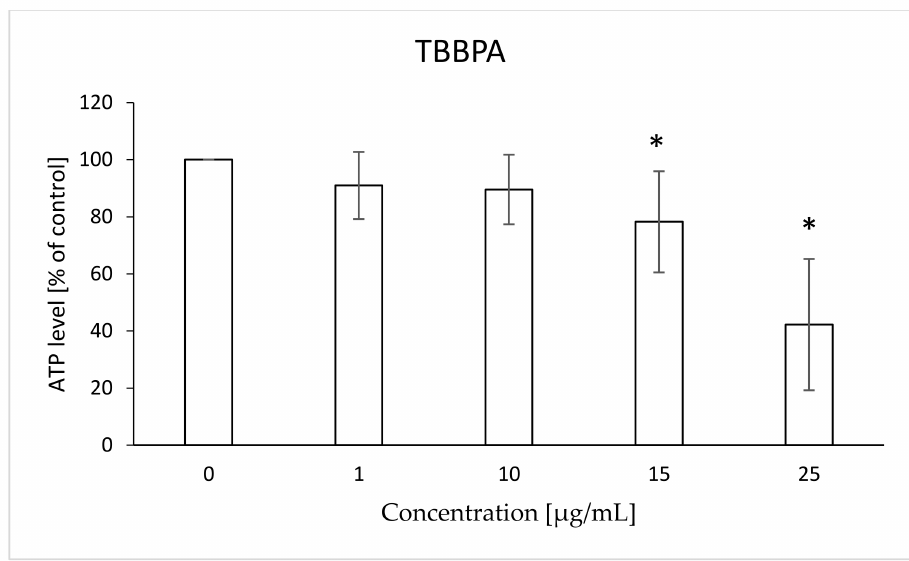
Figure 5. Changes in ATP level in human control erythrocytes and the erythrocytes incubated with TBBPA at 1 to 25 µ g/mL for 12 h. (*) Significantly different from control ( p < 0.05).